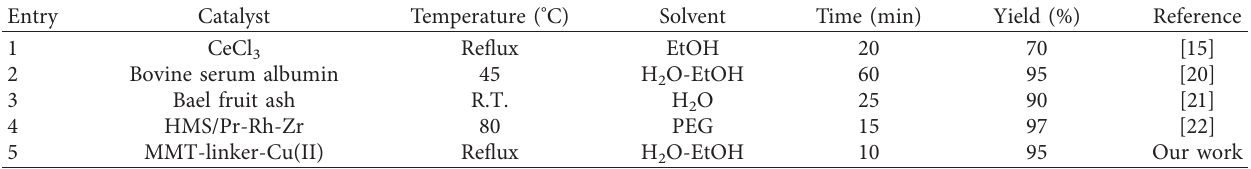
Table 1: Comparison of different methods for the synthesis of bispyrano[2,3-c]pyrazole using terephthalaldehyde, hydrazine, malononitrile, and ethyl acetoacetate as precursors.